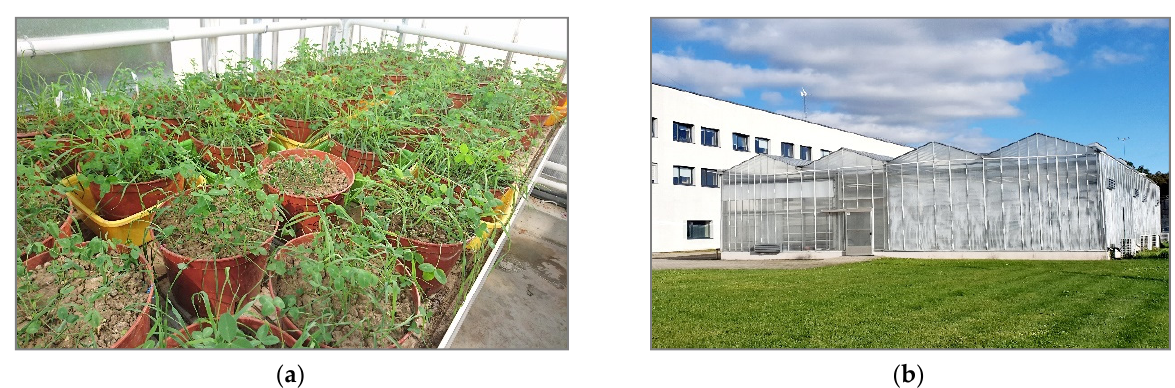
Figure 1. Experimental site: ( a ) General view of greenhouse vegetative experiment of mixtures of red clover and timothy; ( b ) Greenhouse of Vytautas Magnus University Agriculture Academy, Lithuania. Coordinates: 54° 53 ′ 31.65 ″ N, 23° 50 ′ 15.76 ″ E longitude.